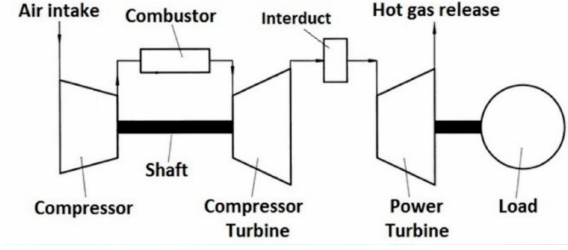
Figure 2. Twin-shaft industrial gas turbine